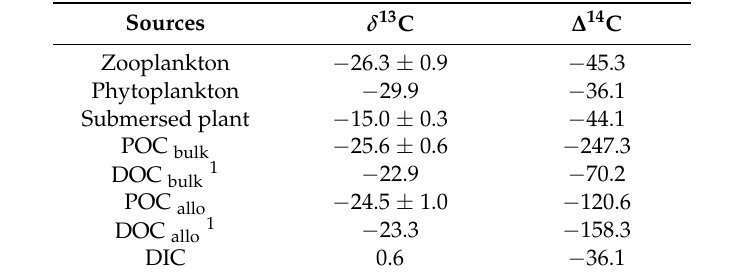
Table 2. The δ 13 C and ∆ 14 C of the zooplankton Arctodiaptomus altissimus pectinatus and its potential carbon sources in Lake Nam Co and its watershed. δ 13 C and ∆ 14 C are given as ‰ deviation from